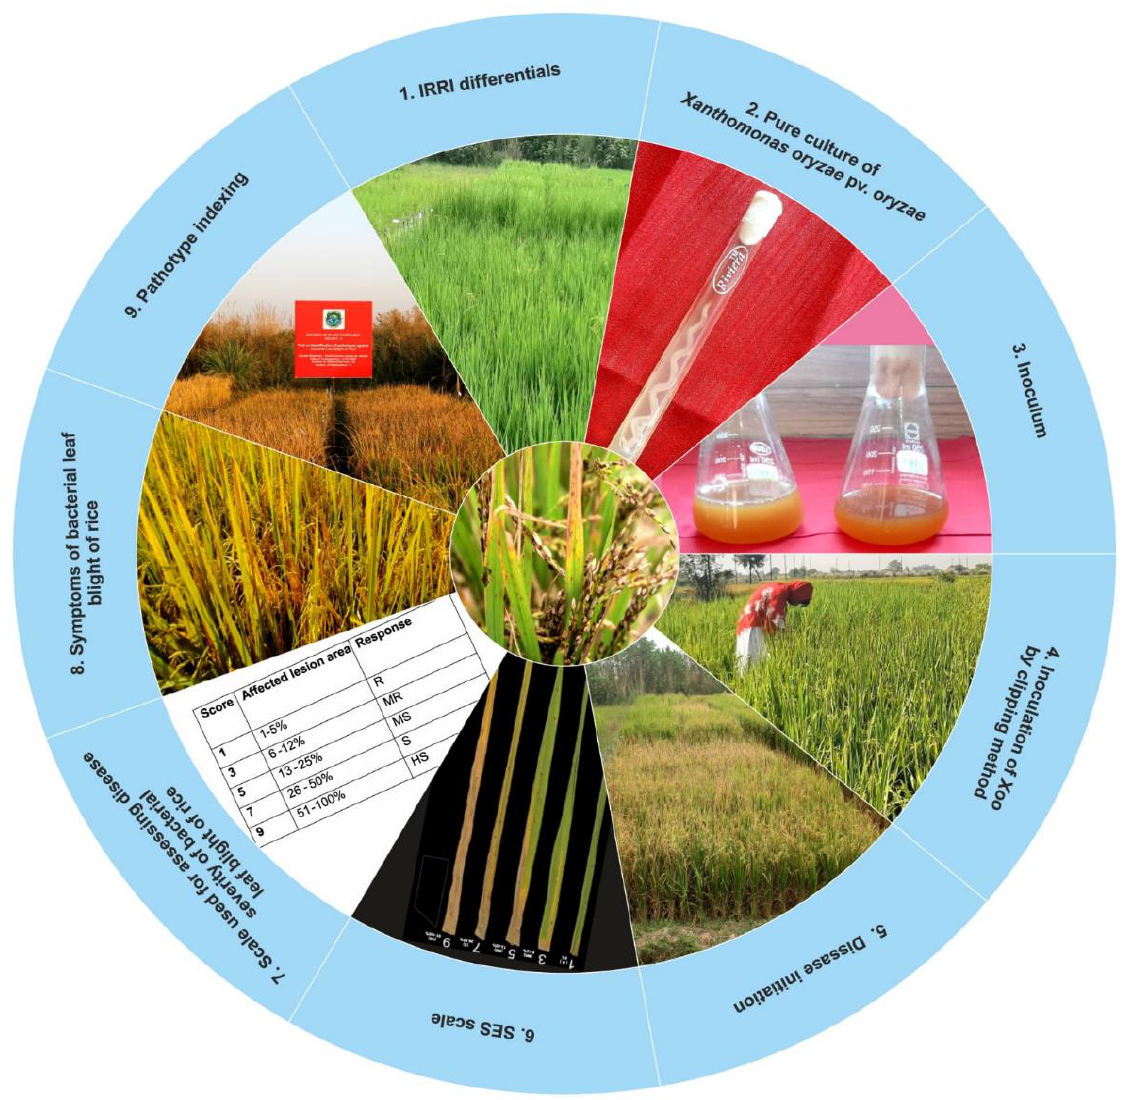
Figure 2. Detailed methodology adopted for pathotype indexing of Xanthomonas oryzae pv. oryzae isolates collected from basmati-rice-growing area of Jammu.